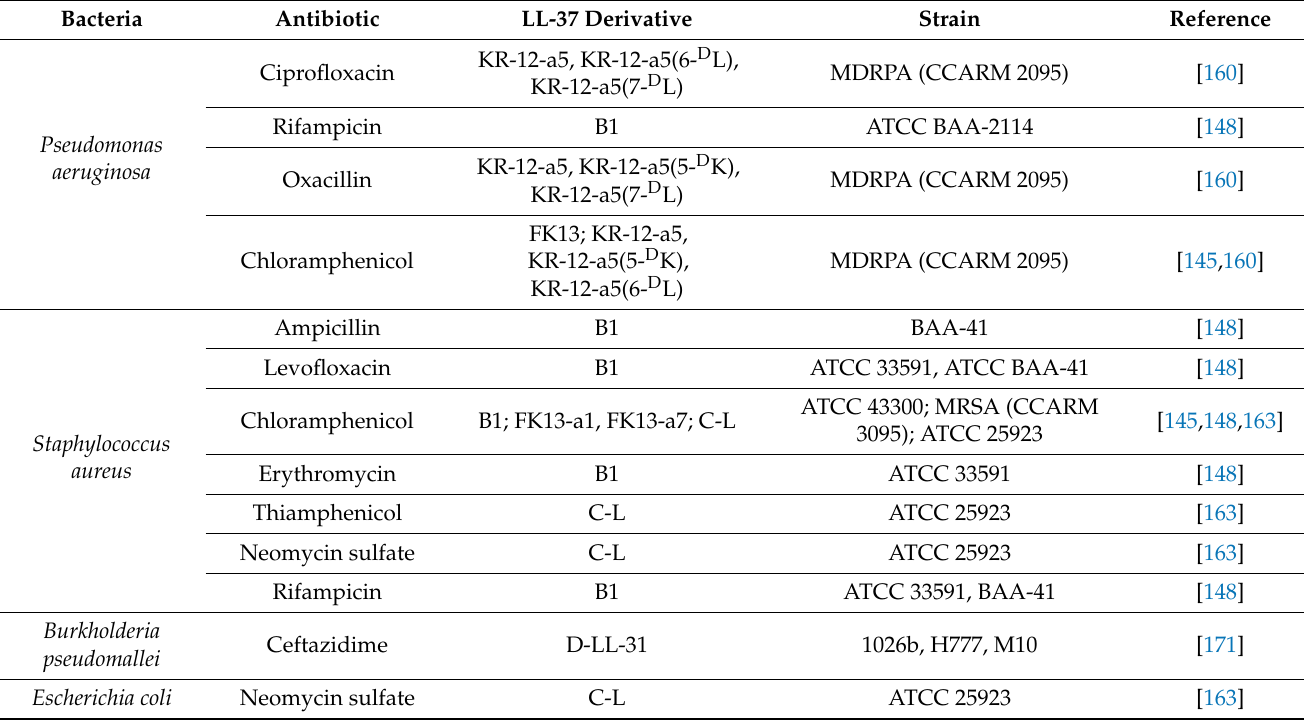
Table 4. Combinations of LL-37-derived peptides and antibiotics that show synergistic effects against specific pathogens. Bacteria Antibiotic LL-37 Derivative Strain